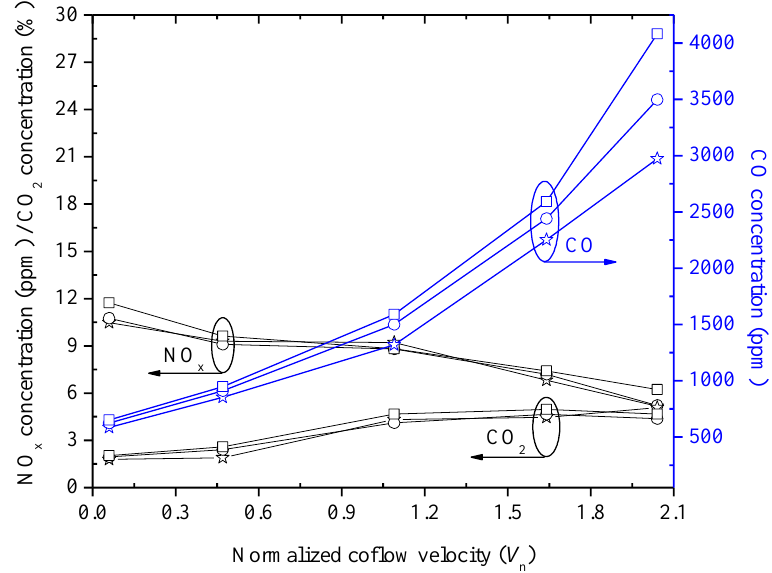
Figure 8. NO x /CO 2 /CO emissions versus N 2 -CO 2 -O 2 coaxial-flow velocity ( ☆ : β = 21%; О: β = 24%; □ : β = 27%).